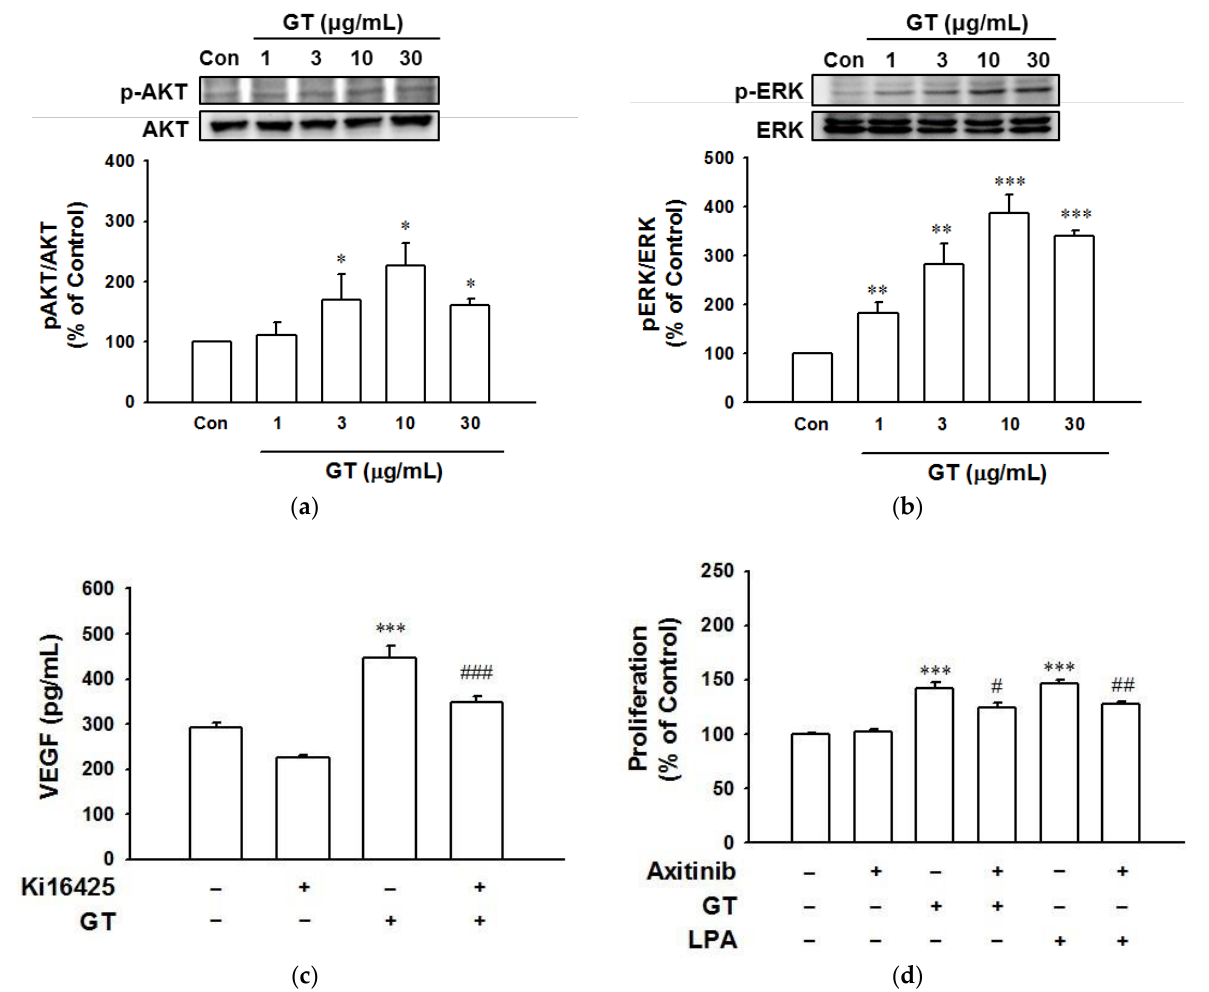
Figure 5. Activation of kinases and changes in receptor inhibitor-induced vascular endothelial growth factor (VEGF) release and proliferation of gintonin-treated HaCaT cells. ( a , b ) Cells were incubated in serum-free medium containing gintonin (GT, 1 –30 μg/mL) for 10 min and harvested for immunoblotting . extracellular signal-regulated kinase (ERK) 1/2 ( a ) and protein kinase B (AKT) proteins ( b ) were detected using corresponding antibodies. Each protein level in untreated cells (Con) was considered as 100%. Data are presented as the means ± S.E.M. ( n = 4); * p < 0.05; ** p < 0.01; *** p < 0.001 vs. untreated cells. ( c ) Cells were incubated in serum-free medium containing gintonin (GT, 10 μg/mL) in the presence or absence of LPA receptor inhibitor Ki16425 (10 μM) for 24 h. The VEGF level in the conditioned medium was measured using the ELISA kit as described in the Materials and Methods section. Data are presented as the means ± S.E.M. ( n = 4); *** p < 0.001 vs. untreated cells; ### p < 0.001 vs. GT alone. ( d ) Cells were incubated in serum-free medium with gintonin (GT, 10 μg/mL) or lysophosphatidic acid (LPA, 10 μM) in the presence or absence of VEGF receptor inhibitor axitinib (10 μM) for 24 h. Then , the XTT-based proliferation assay was performed. LPA was used as a positive control. Response of untreated cells was considered as 100%. Data are presented as the means ± S.E.M. ( n = 6); *** p < 0.001 vs. untreated cells; # p < 0.05; ## p < 0.01 vs. GT or LPA alone. p-ERK, phospho-ERK1/2; p-AKT, phospho-AKT.